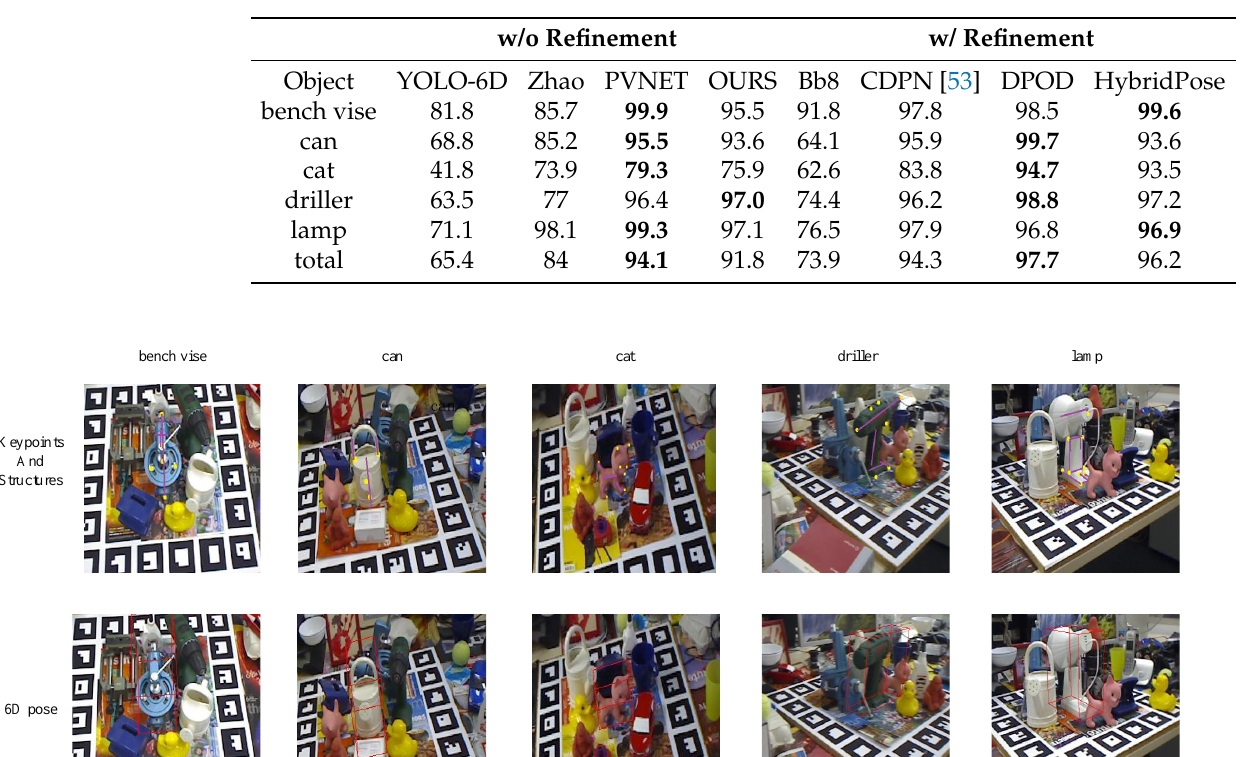
Table 8. Comparison with the state-of-the-art methods in terms of the ADD reprojection metric on LineMOD dataset. Bold number indicates the best results.